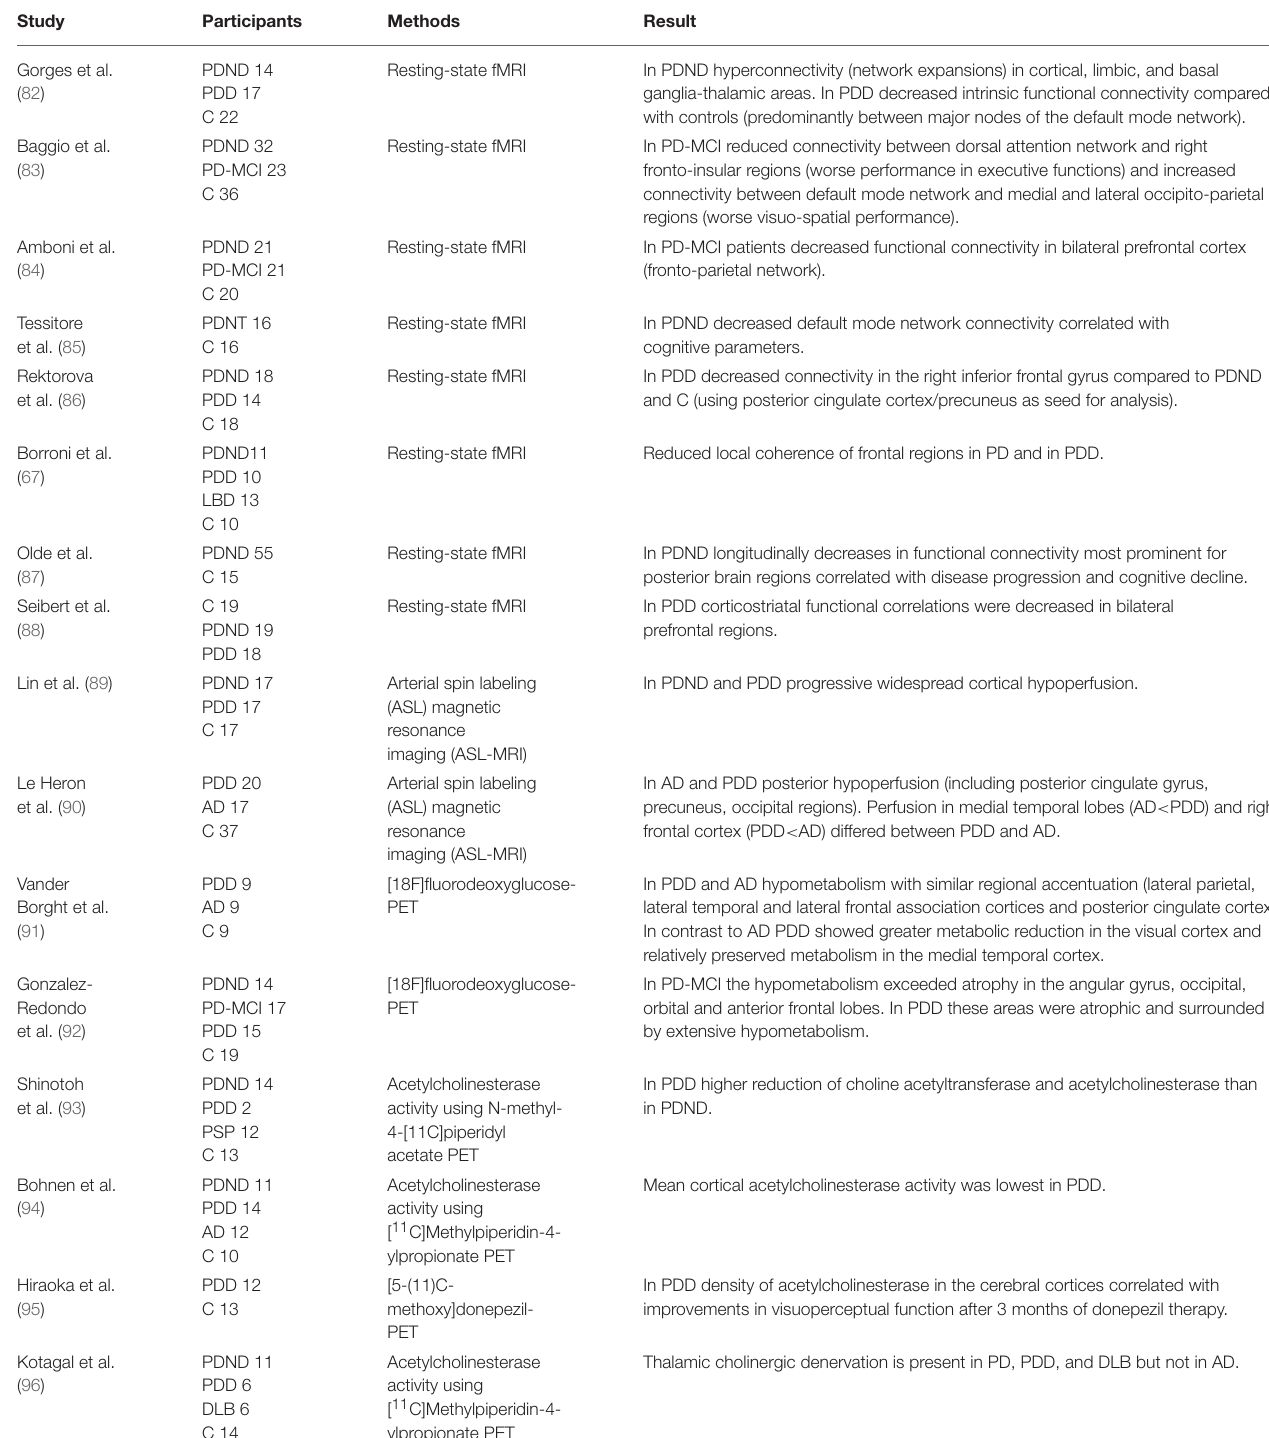
TABLE 3 | Changes of function and connectivity related to cognitive impairment and dementia in Parkinson’s disease.